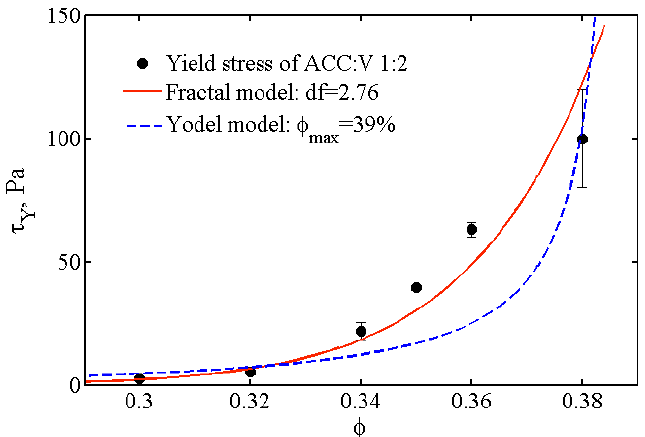
Figure 8. Dependence of the yield stress of ACC:V (1:2) paste with the volume fraction. Comparison of the experimental data with the Yodel model [22] (blue curve) and the fractal model of Shi et al. [24] (red curve).